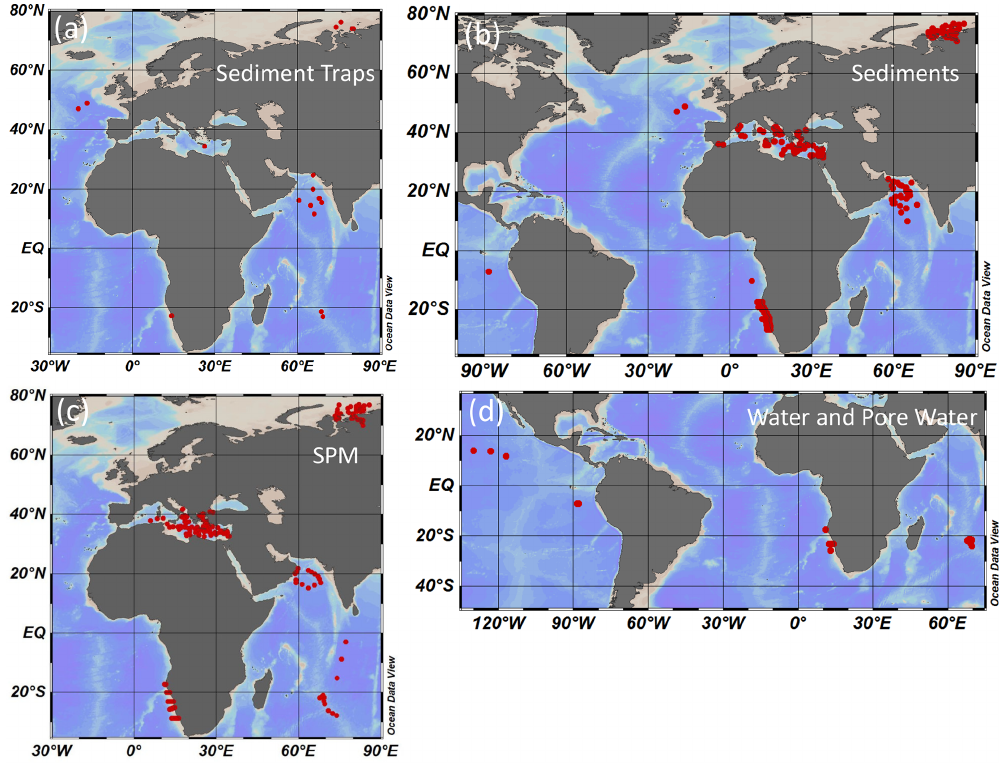
Figure 1. Stations of sediment trap deployments (a) , sediment (b) , SPM (c) , and water and pore water sampling (d)